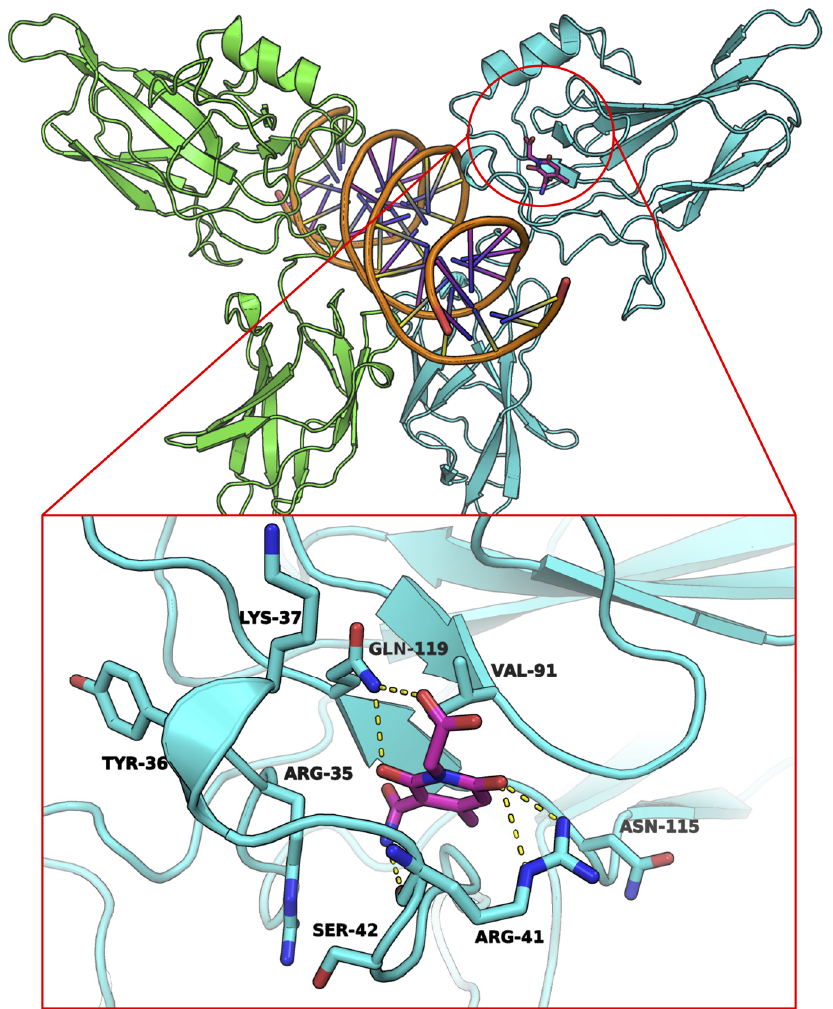
Figure 4. Molecular docking-predicted binding mode. Molecular docking-predicted binding mode of A55 (magenta atom colored sticks) to the RelA binding pocket near the DNA-binding interface. Yellow dashes represent hydrogen bonds between A55 and the amino acid residues of pocket 1.